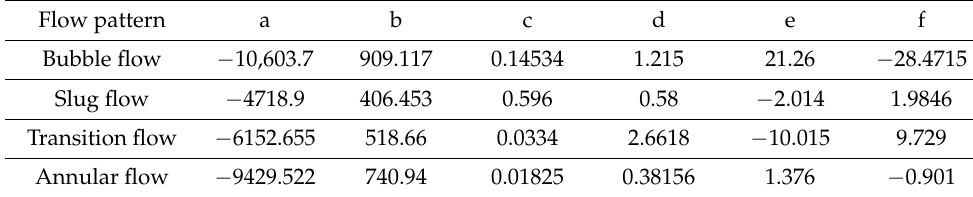
Table 5. Coefficient regression in the new model.